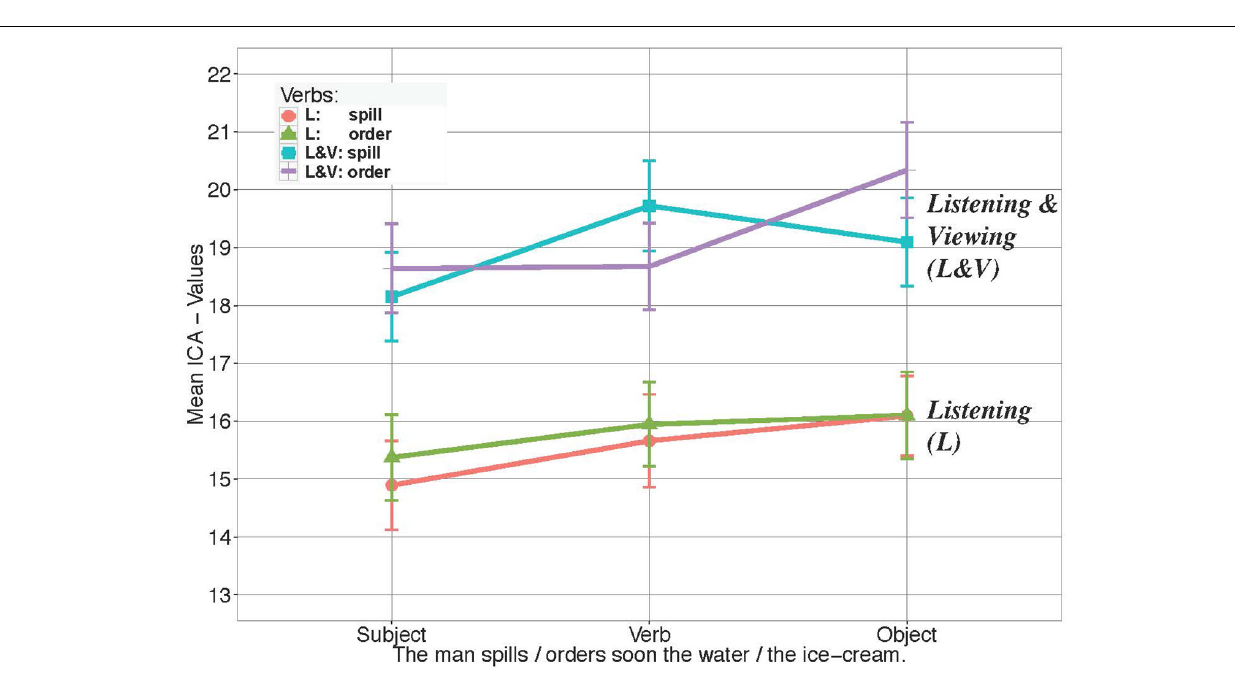
FIGURE 5 | Comparison of ICA values in Experiment 2 and Experiment 3. Both object nouns of a verb condition are considered together for the plot. Graphs show the significant main effect of Experiment and a significant interaction of Verb and Experiment. Error bars reflect 95% confidence intervals (CI). For the models see Supplementary Materials